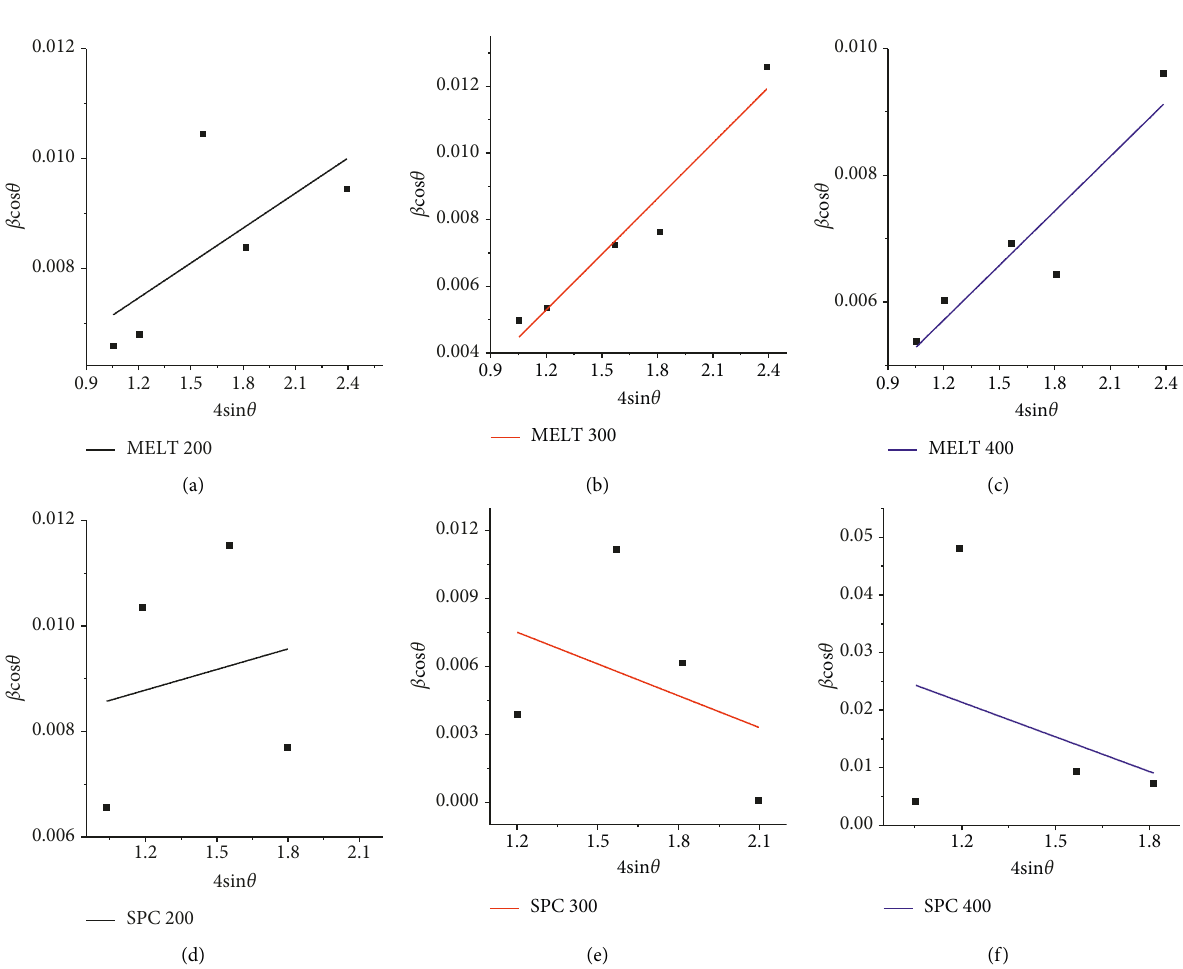
Figure 8: W-H plot analysis of NiS films obtained by spin-coating and nanoparticles obtained from the solventless method. Table 3: Crystallite size and strain of NiS films obtained by spin-coating and nanocrystals obtained from the solventless method at 200 ° C, 300 ° C, and 400 ° C. Temperature Parameter Spin coating